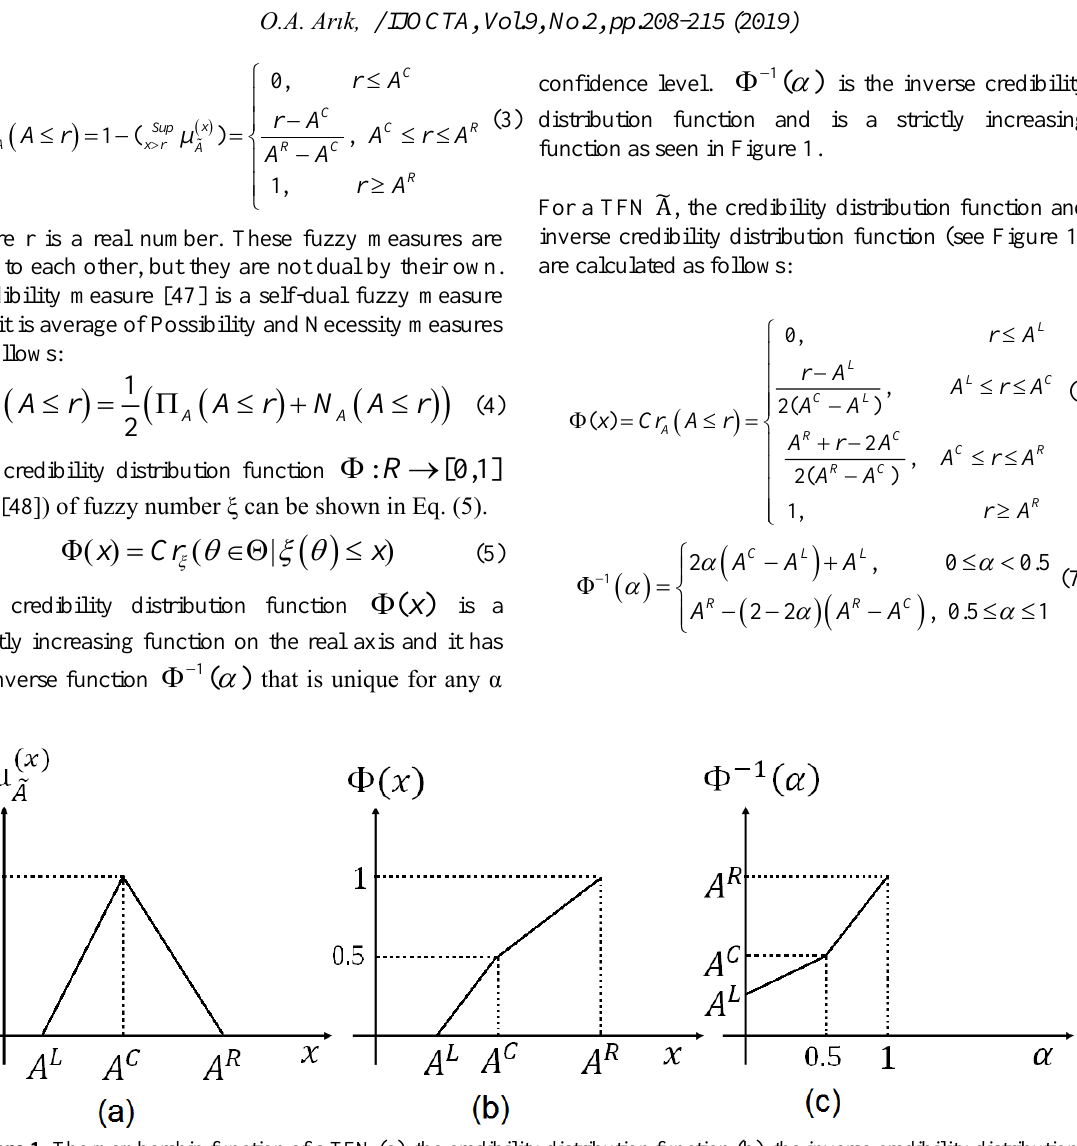
Figure 1. The membership function of a TFN (a), the credibility distribution function (b), the inverse credibility distribution function